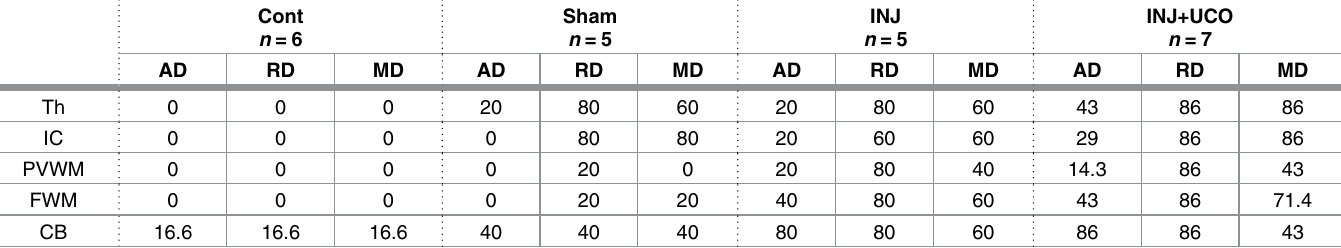
Table 2. Percentage of lambs found to have AD, RD, and MD in the selectedWM regions of each group below the colour map threshold intensity 90% confidence interval of the Cont group.